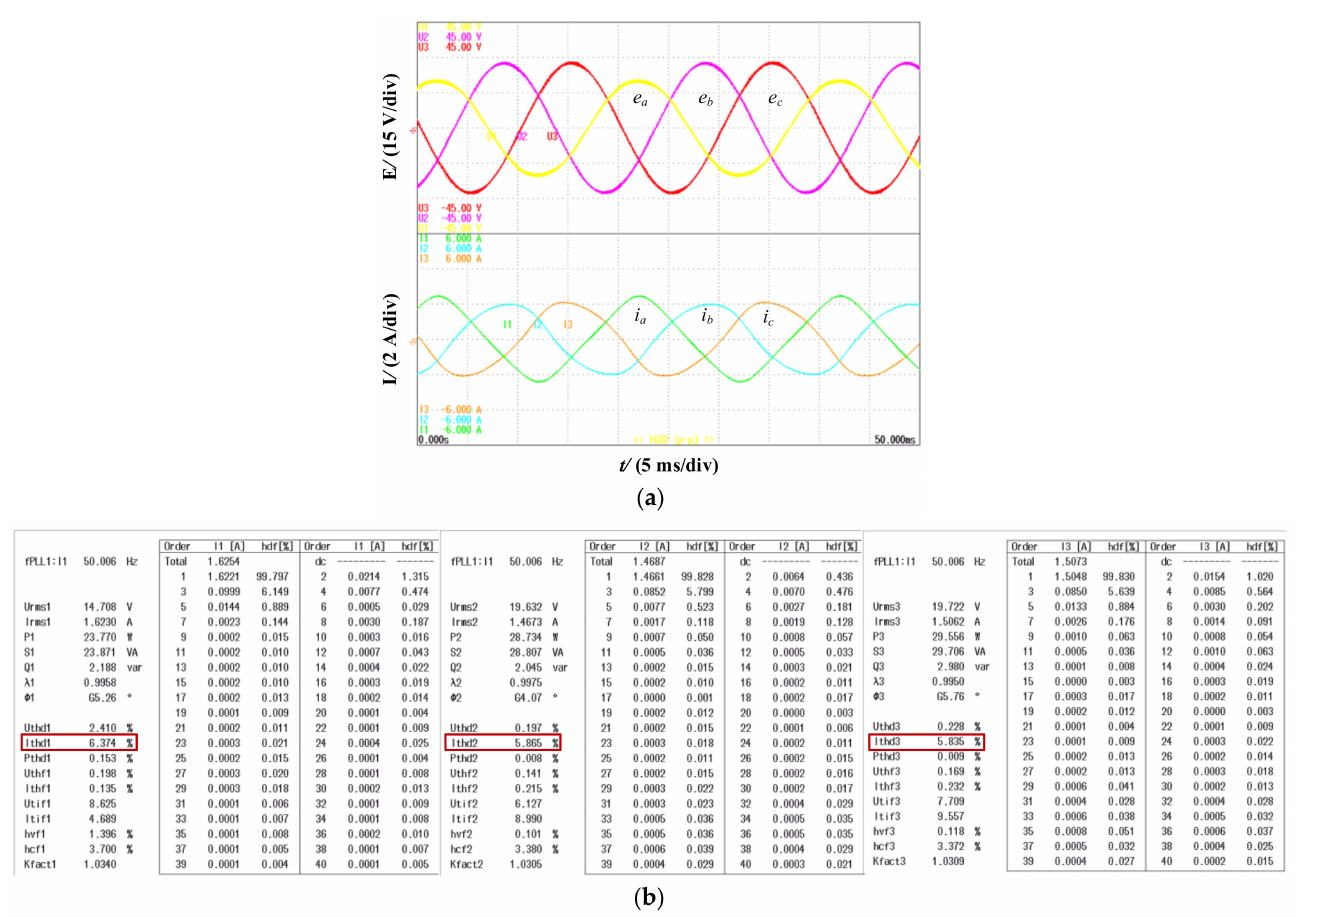
Figure 11. Experimental results of conventional FCS-MPDPC under unbalanced grid voltages; ( a ) voltage and current waveforms; ( b ) spectrum analysis of